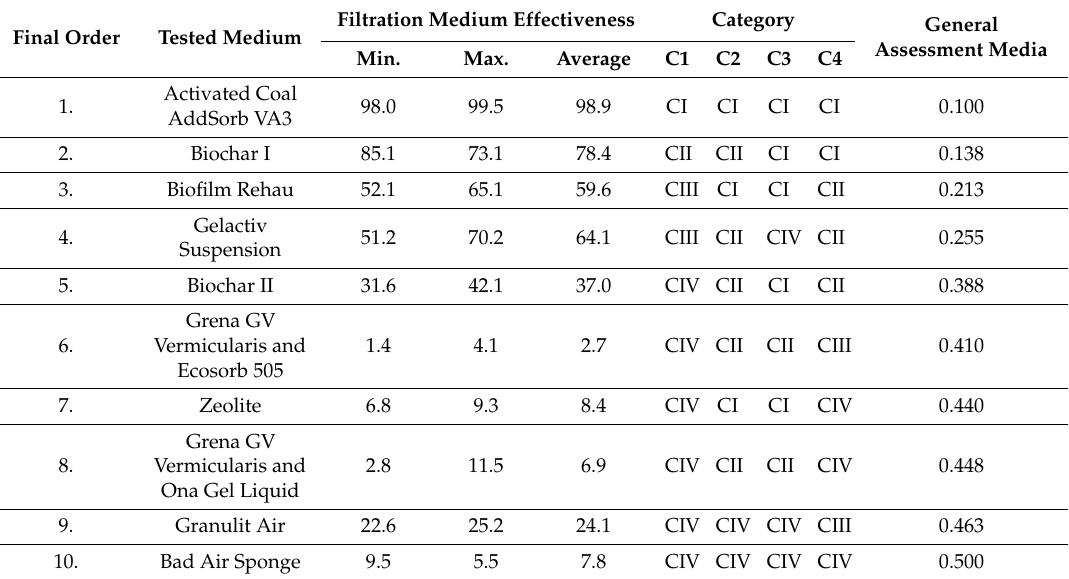
Table 7. Recommendations for applications of filtration media in sewerage